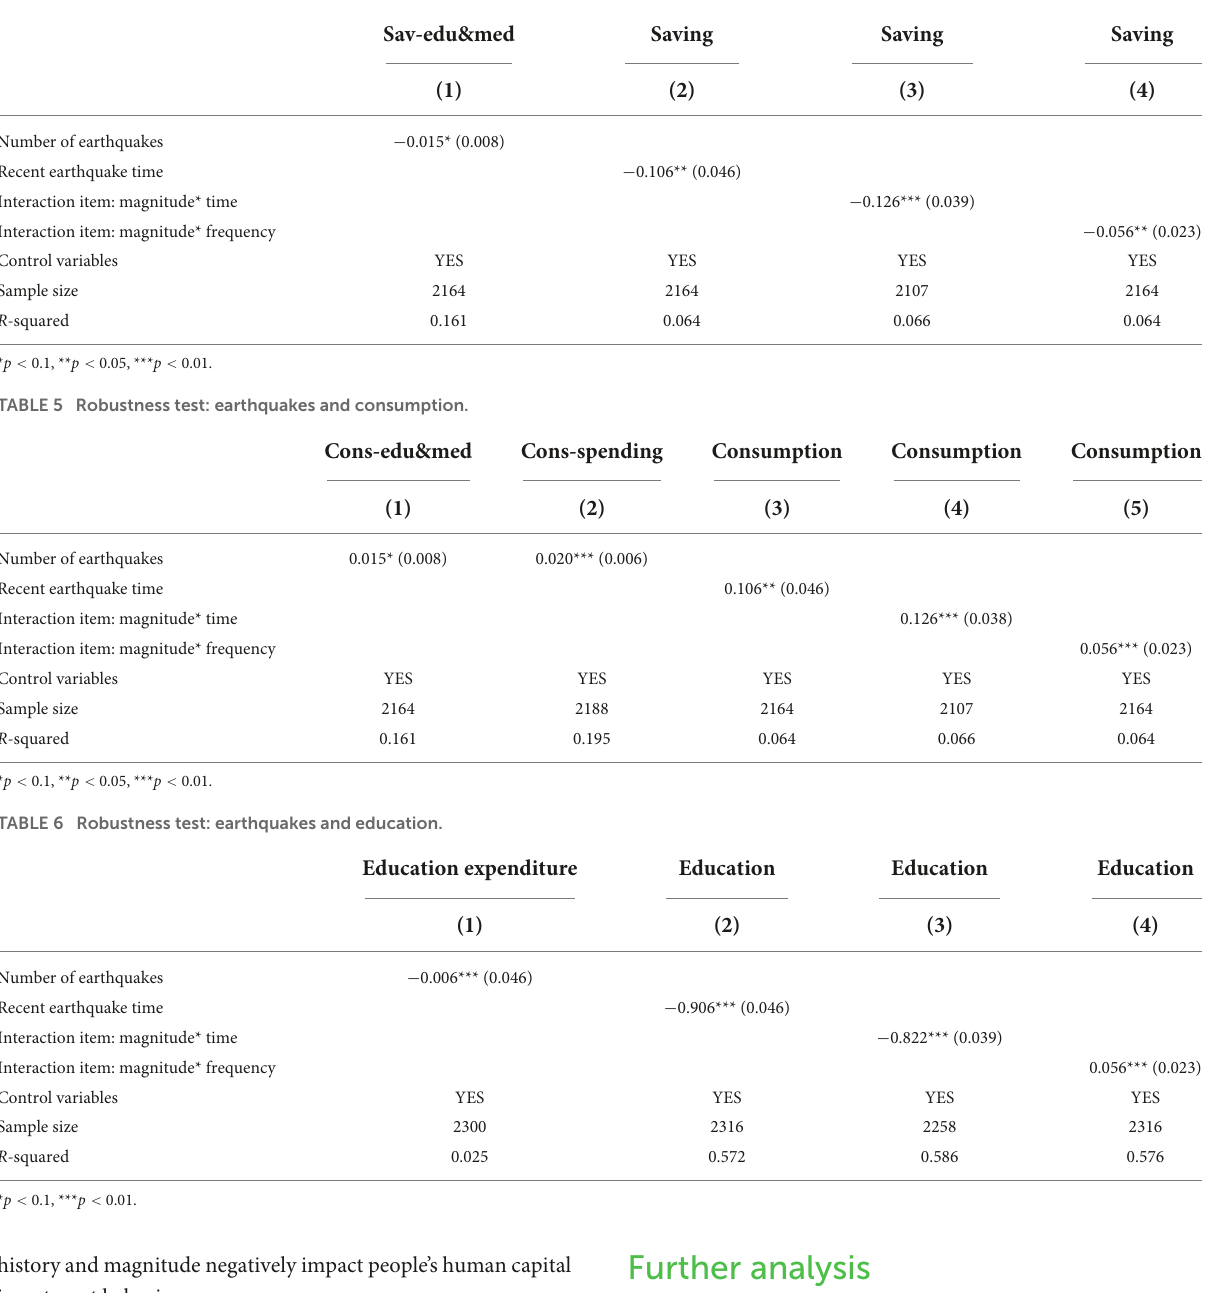
TABLE 4 Robustness test: earthquakes and savings.